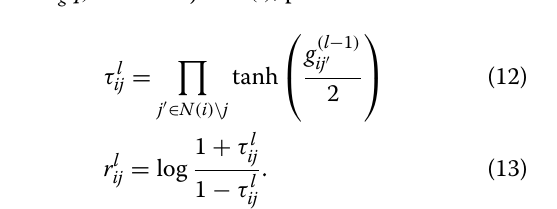
decoding. We denote the set of symbol nodes that par- ticipate in check node c i by N ( i ) = { j : P ij = 1 } , and the set of check nodes in which s j participates as M ( j ) = { i : P ij = 1 }